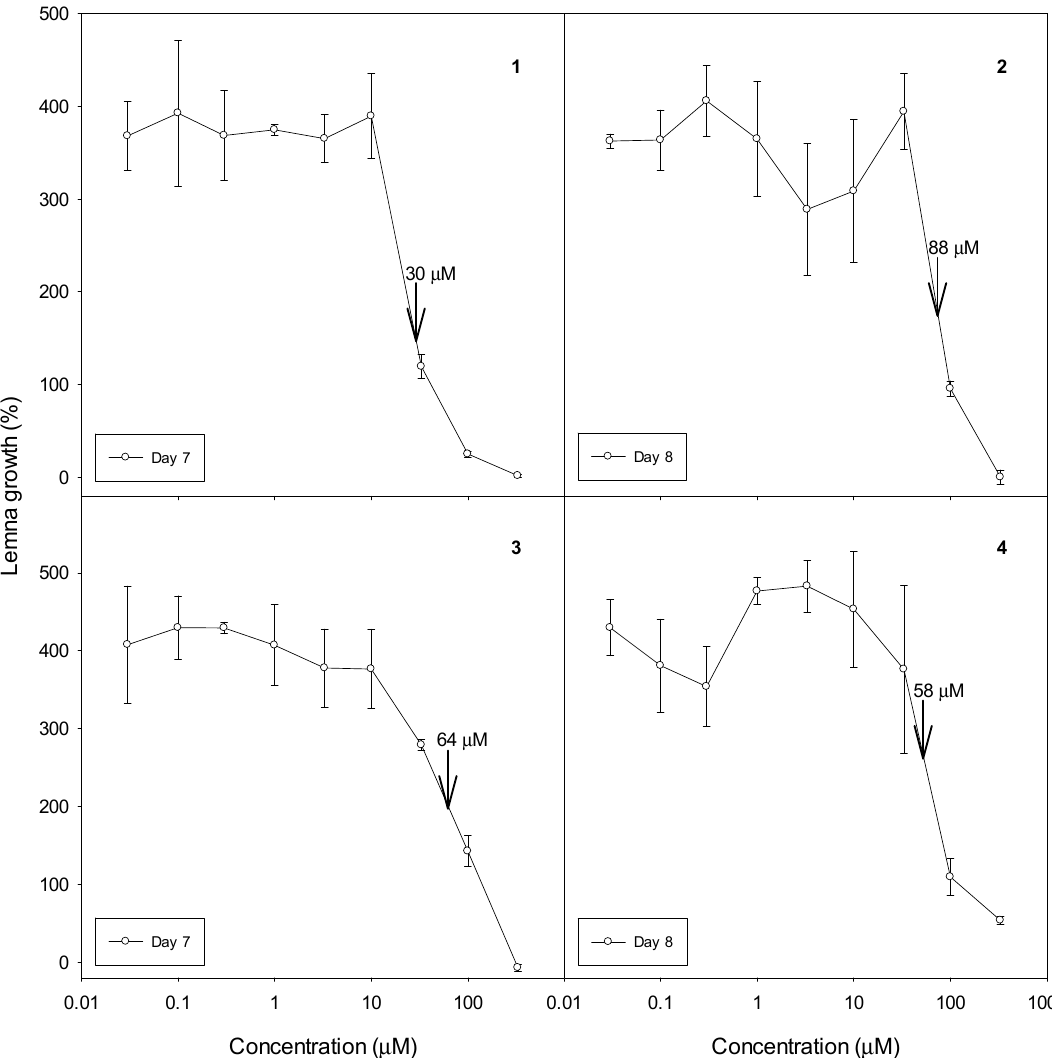
Figure 3. Dose/response curves for the four isolated compounds in a L. paucicostata bioassay. Error bars are ±SE of the mean. Arrows with numbers denote the concentration that inhibits growth by 50%. ( 1 ) 8(9),15-isopimaradien-1,3,7,11-tetraone; ( 2 ) 7-oxo-8,11,13-cleistanthatrien-3-ol; ( 3 ) 3,20-epoxy-7-oxo-8,11,13-cleistanthatrien-3-ol; ( 4 ) 20-nor-3,7-dioxo-1,8,11,13-cleistanthatetraen-10-ol.